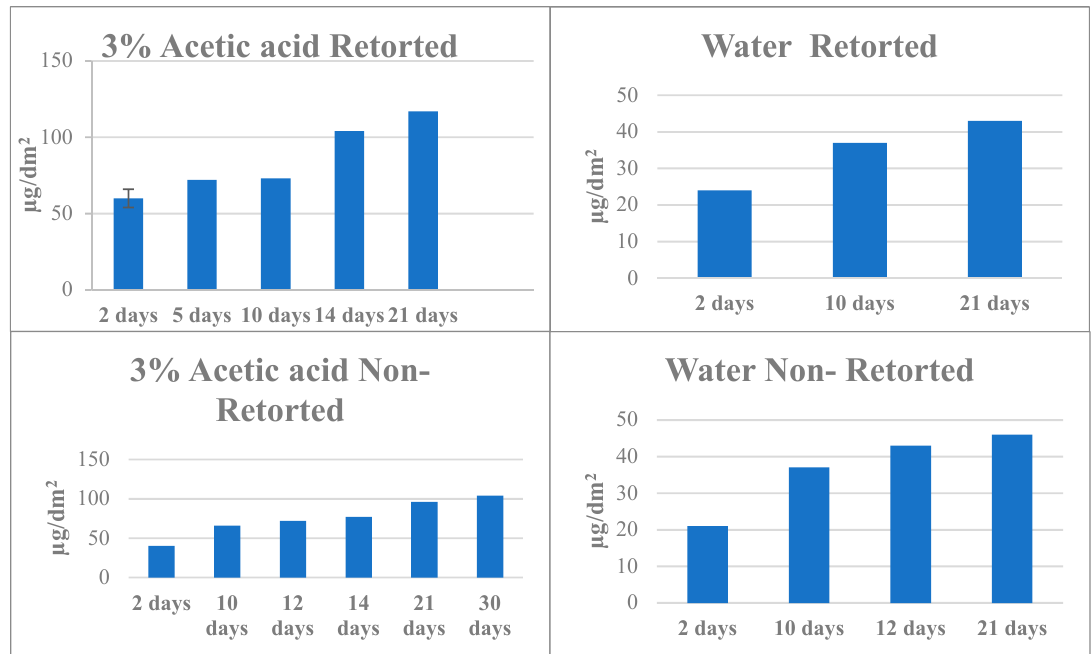
Figure 4. Concentrations of BGA from vinyl coatings in water and 3% acetic acid food simulant at 60 °C during the accelerated migration test. Results expressed in µg/dm 2 .